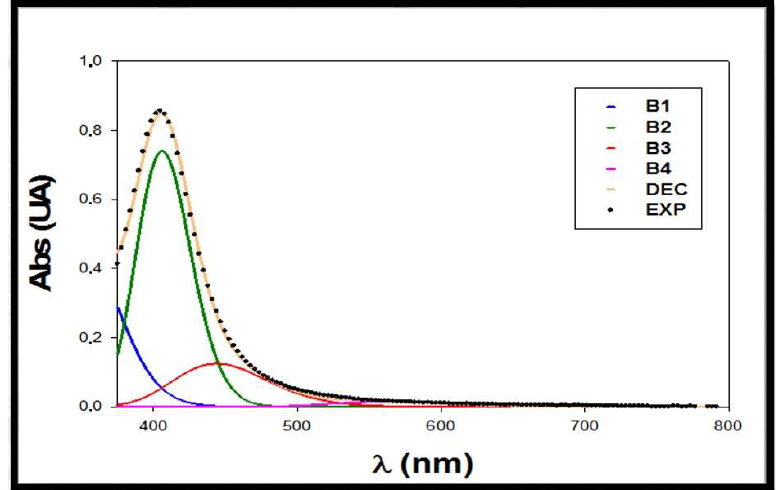
Figure 8. Deconvoluted spectra of a mixture citrate + PVP-AgNPs:mineral water sample. EXP: experimental spectra; DEC: deconvoluted spectra; B1: sample matrix band; B2: free silver nanoparticles in solution band; B3: silver nanoparticles interacting with Al(III) band in mineral water sample; and B4: aggregated silver nanoparticles band.